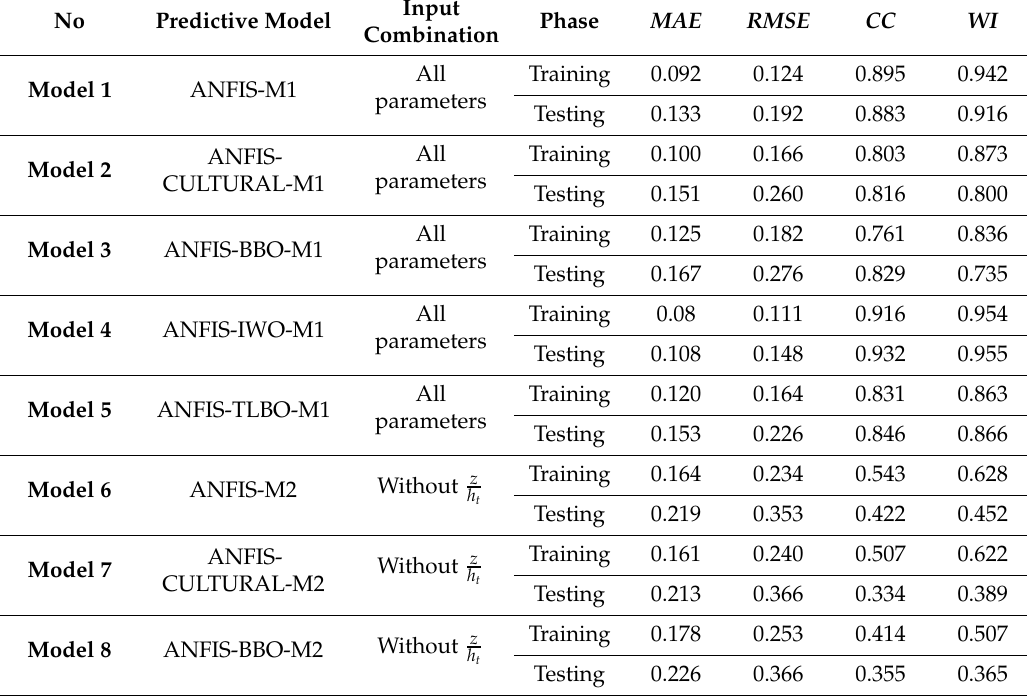
Table 4. The performance indices obtained through di ff erent predictive models for predicting the scouring depth downstream of